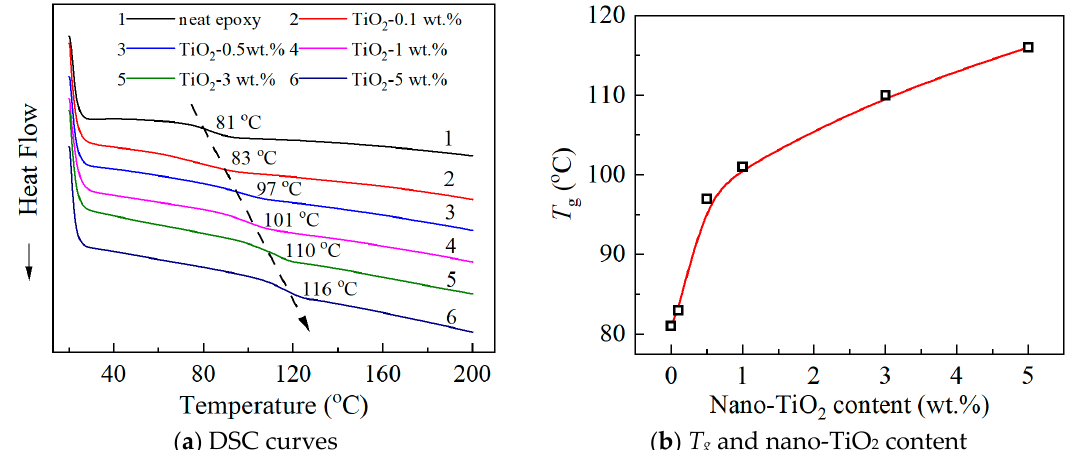
Figure 3. DSC curves and T g of neat epoxy and epoxy/TiO 2 nanocomposites. ( a ) DSC curves; ( b ) T g and nano-TiO 2 content.